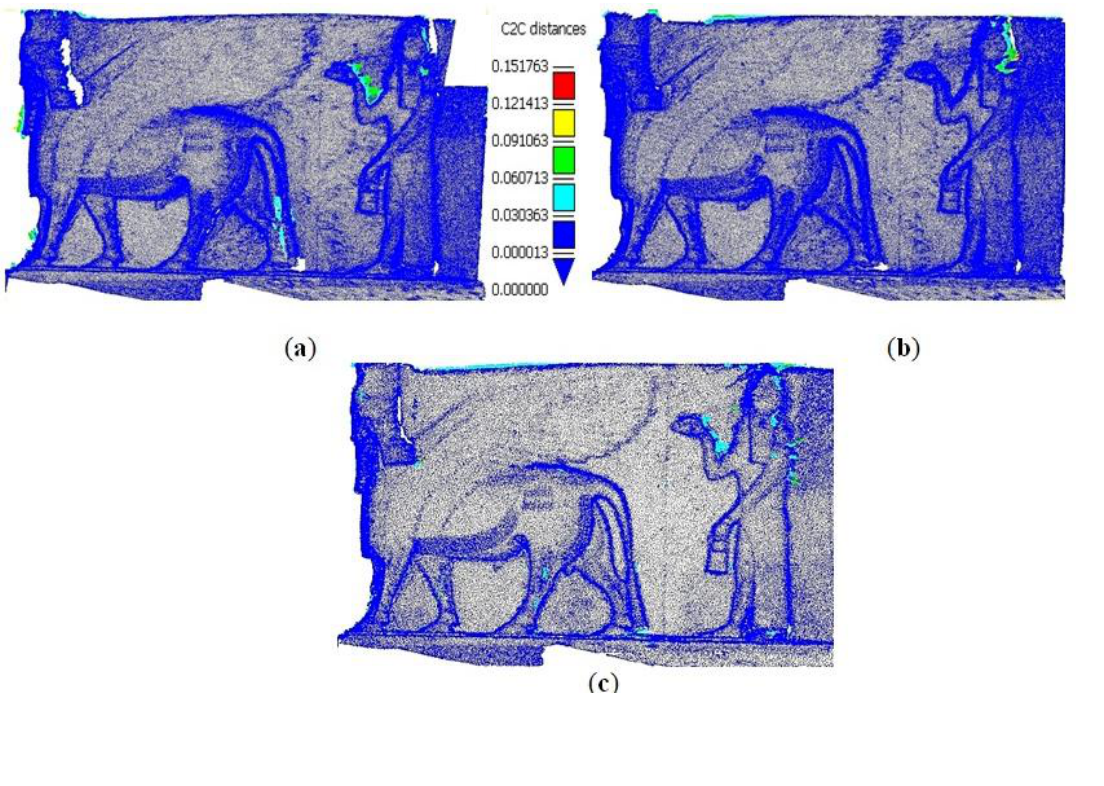
Figure 19. Comparison between the point clouds resulted from filtering networks and the dense network. ( a ) Filtered network for coverage; ( b ) Filtered network for accuracy; ( c ) Filtered with